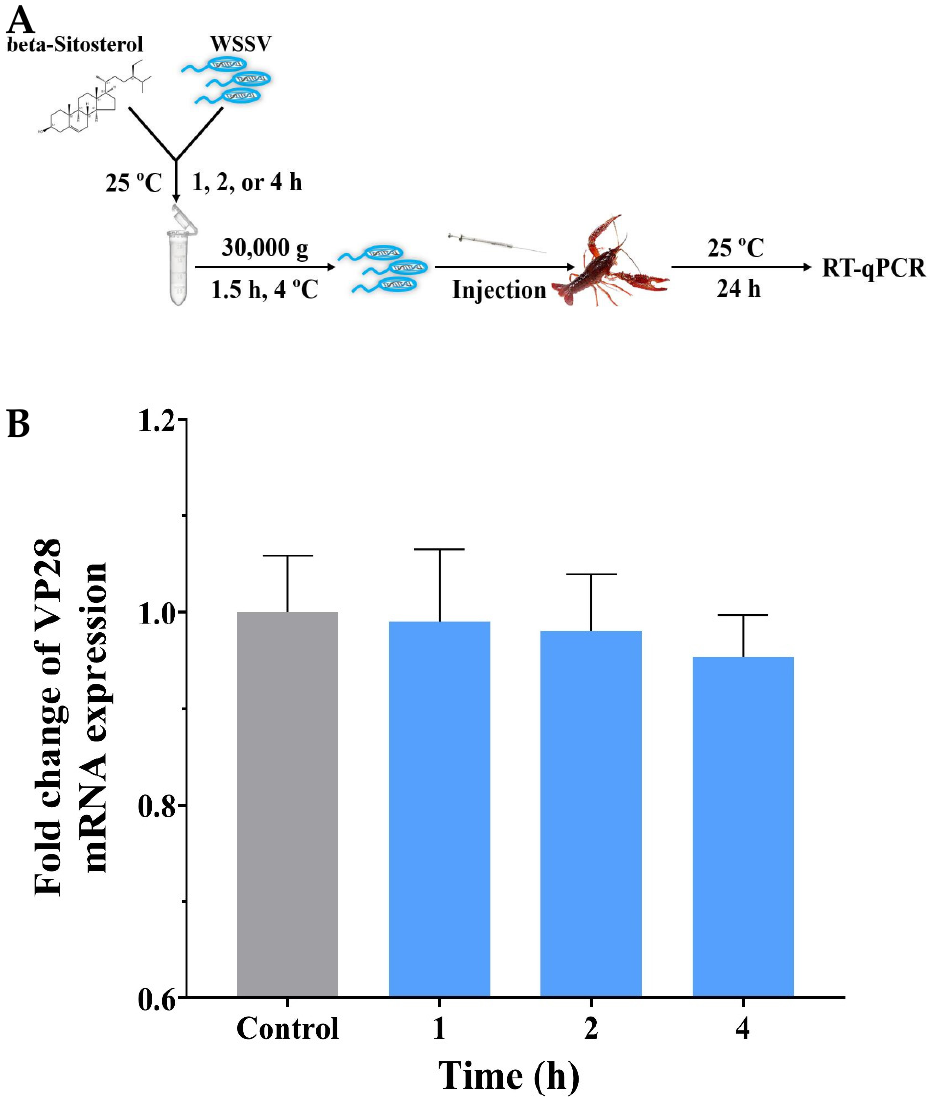
Figure 4. The effects of beta-sitosterol on WSSV infectivity in vitro. ( A ) The experimental workflow. ( B ) Detection of transcript levels of the VP28 gene. The 18S gene served as an internal reference. The data are shown as mean ± SD (n = 5).